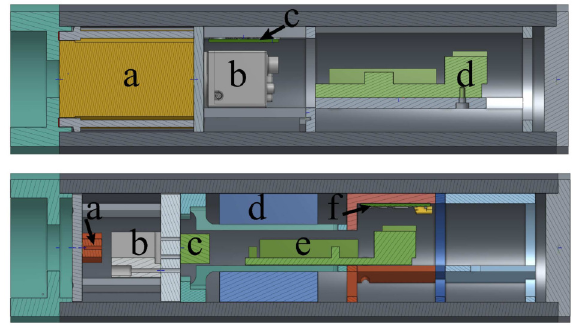
Figure 3. Cross-sections of the CAD models: the top image sho ws the camera housing and the bottom image shows the housing of the cross line laser